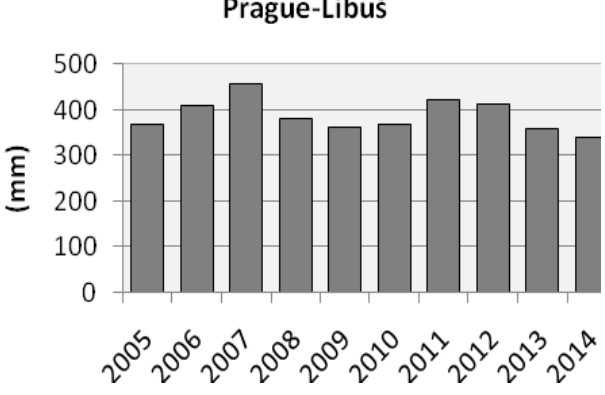
Fig. 7. Prague-Libuš, evaporation from water surface between 1 st May and 30 th September (2005-2014)